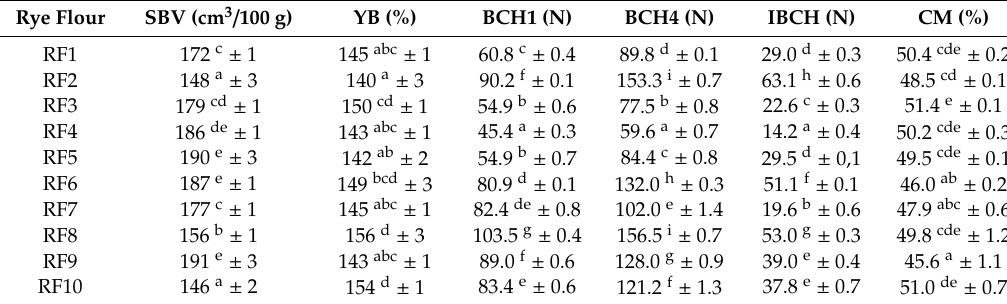
Table 4. The quality parameters of rye